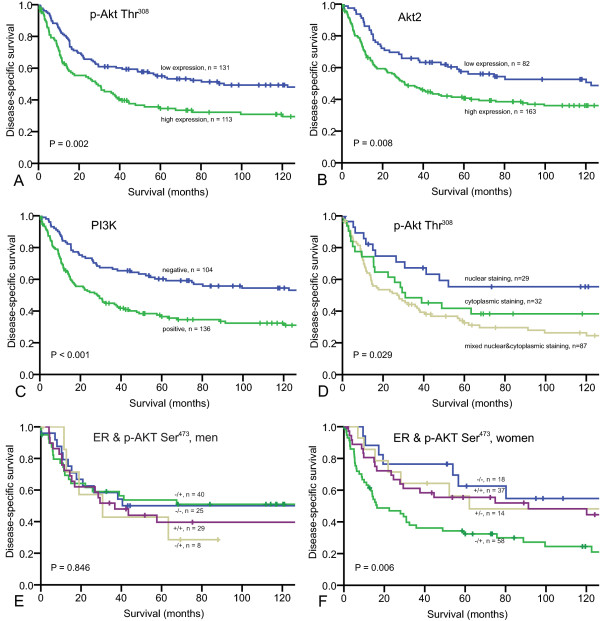
Disease-specific survival curves for the investigated markers, their expression pattern and coexpression with steroid hormone receptors. A, p-Akt Thr308; B, Akt2; C, PI3K; D, p-Akt Thr308, by cellular expression pattern; E, p-Akt Ser473 in coexpression with ER, men; F, p-Akt Ser473 in coexpression with ER, women. Abbreviations: p-Akt Thr308, Akt phosphorylated at threonin 308; PI3K, phosphoinositide 3-kinase; p-Akt Ser473, Akt phosphorylated at serin 473; ER, estrogen receptor.